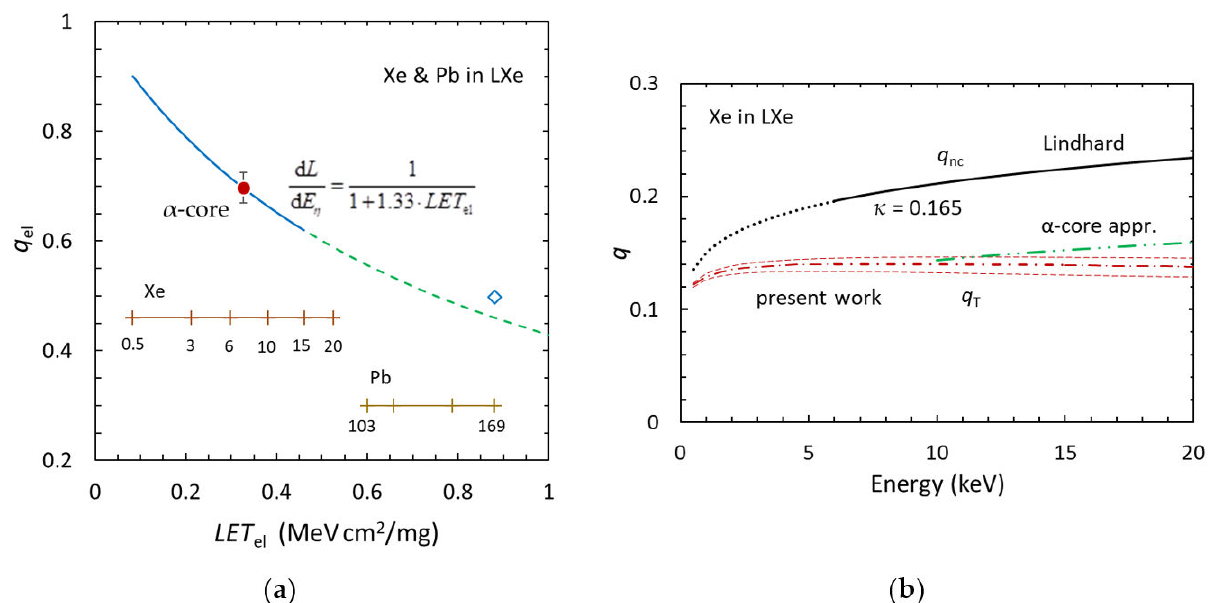
Figure 5. Quenching factors in liquid Xe: ( a ) The electronic quenching factor q el , estimated for Xe and Pb recoils as a function of LET el . A closed circle shows q c = 0.70 for 5.49 MeV α -particle. Curves show Birks’ law. Horizontal scales show the energy of Xe and Pb recoils in keV; the diamond show a value corrected for core expansion: ( b ) Quenching factors calculated for Xe recoils in liquid Xe as a function of the energy. The solid curve shows Lindhard q nc , the dotted curve is an extrapolation. The dot-dashed curve shows the total quenching factor q T = q nc · q el . The dashed curves show uncertainties due to the estimated T c / T ratio, 0.76 ± 0.04, in α track. The q T curve may approach to Lindhard q nc curve faster than the dot-dashed curve as the energy decreases below about 2 keV (see Sections 4.1 and 4.2). The result obtained previously by the α -core approximation is shown with a dot-dot dashed curve